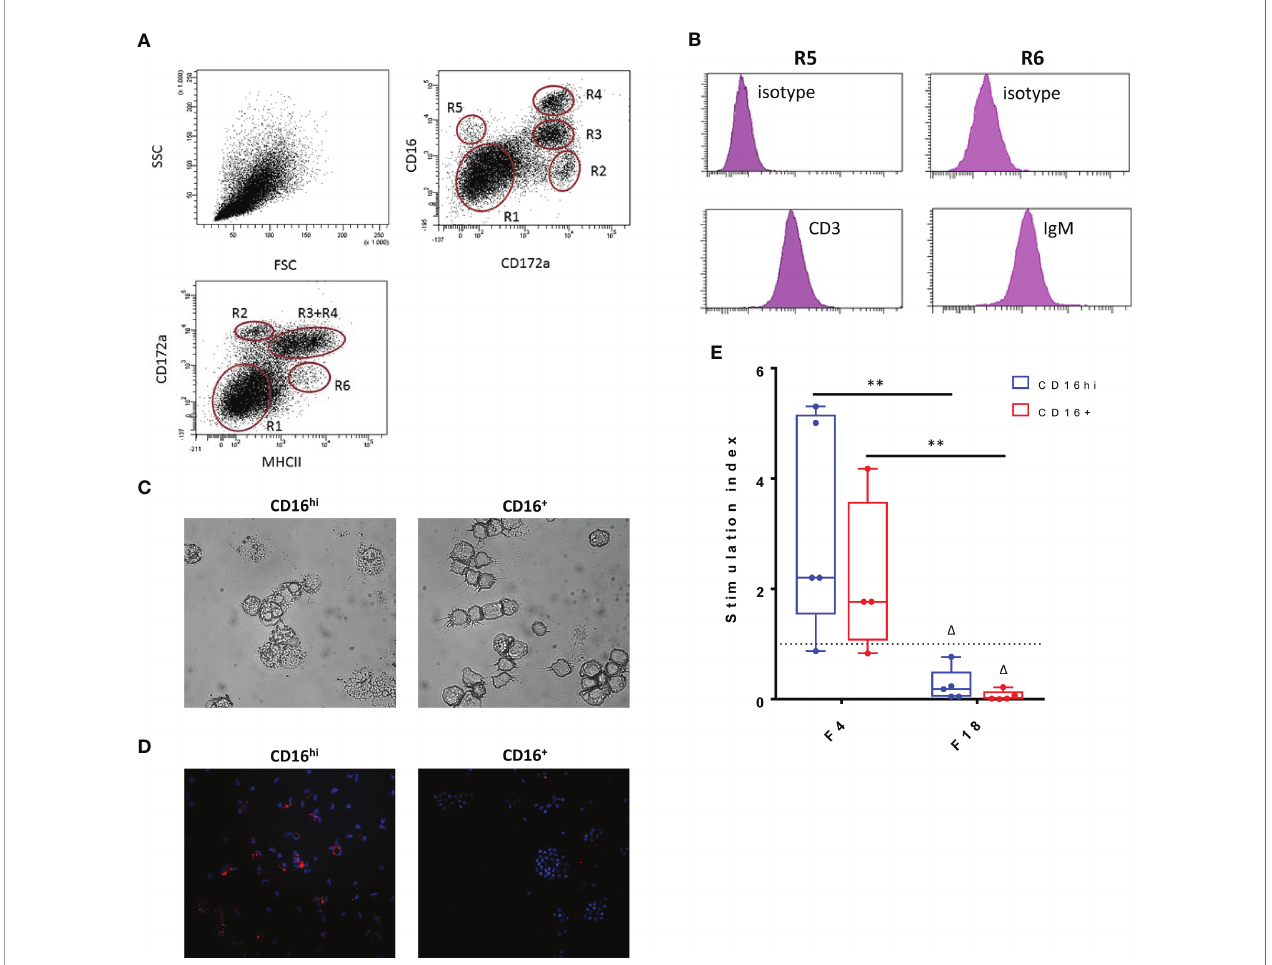
FIGURE 8 | In fl uence of F18 fi mbriae on antigen presenting capacity of intestinal antigen presenting cells. (A) Phenotypical analysis of small intestinal lamina propria mononuclear cells (LP MC). LP MCs were stained to determine CD172a, CD16 and MHCII expression in the live cell gate (CytoxBlue neg.) upon doublet discrimination. R1: lymphocytes; R6: MHCII + activated T- and B-cells; R5: CD3 + T cells; R2-R4: myeloid cells. Representative plots for fi ve separate experiments. (B) The LP MC population R6 consists mainly of IgM + B-cells, while CD3 + T-cells make up the R5 population. (C) Morphological differences between CD16 hi and CD16 + populations. (D) Macrophage-speci fi c staining (CD68; red) of CD16 hi and CD16 + population. Cell nuclei are shown in blue (Hoechst staining). (E) Both CD16 hi and CD16 + iAPCs (1.0 x 10 4 ) were stimulated for 24h with the indicated agents (x-axis) and co-cultured with 1.0 x 10 5 CD6 + T-cells for 5 days. Proliferative responses were measured via the incorporation of tritiated thymidin (n = 5). Control = 1432 +/- 4332 cpm, ConA = 23833 +/- 16056 cpm. Multiplicity adjusted p-values: D p < 0.05; **p < 0.01. * indicates signi fi cant differences between the stimulated conditions (F4 and F18 fi mbriae), while D indicates signi fi cant differences compared to the mock- stimulated iAPCs. cpm: counts per